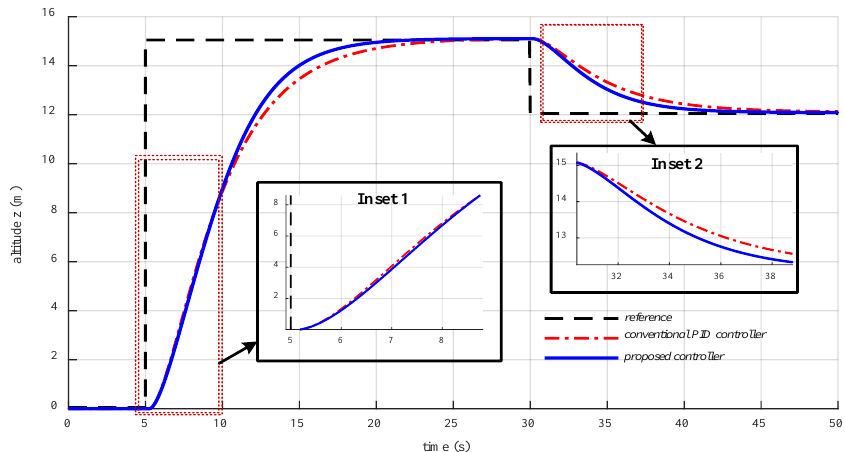
Figure 7. Comparison of altitude performance between our new controller and a conventional PID controller for Scenario 1 (tracking a step altitude reference).